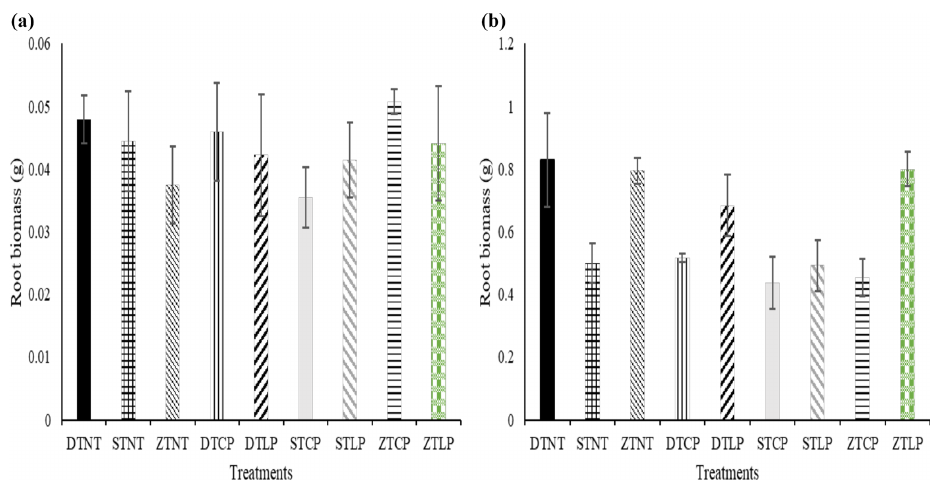
Figure 2. Root biomass at tillering (GS 25) and flowering (GS 61) for the traffic and tillage treatments. Treatments are represented by initials. For tillage, the abbreviations for the treatments are D – deep, S – shallow, and Z – zero; the abbreviated treatments for traffic are NT – no traffic, LP – low-pressure tyre, and CP – conventional-pressure tyre.